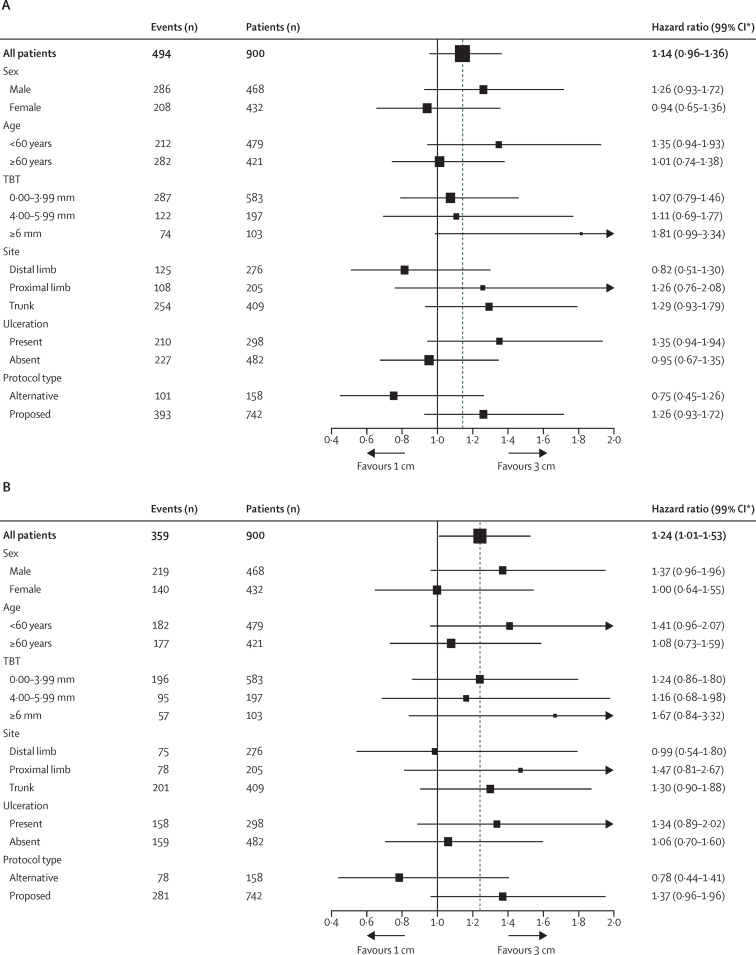
Univariable subgroup analyses of overall survival (A) and melanoma-specific survival (B)The dotted line shows the hazard ratio for all patients. Data excludes patients with unknown values for each variable. TBT=total Breslow thickness. *95% CIs presented for all patients; 99% CIs presented for subgroups.